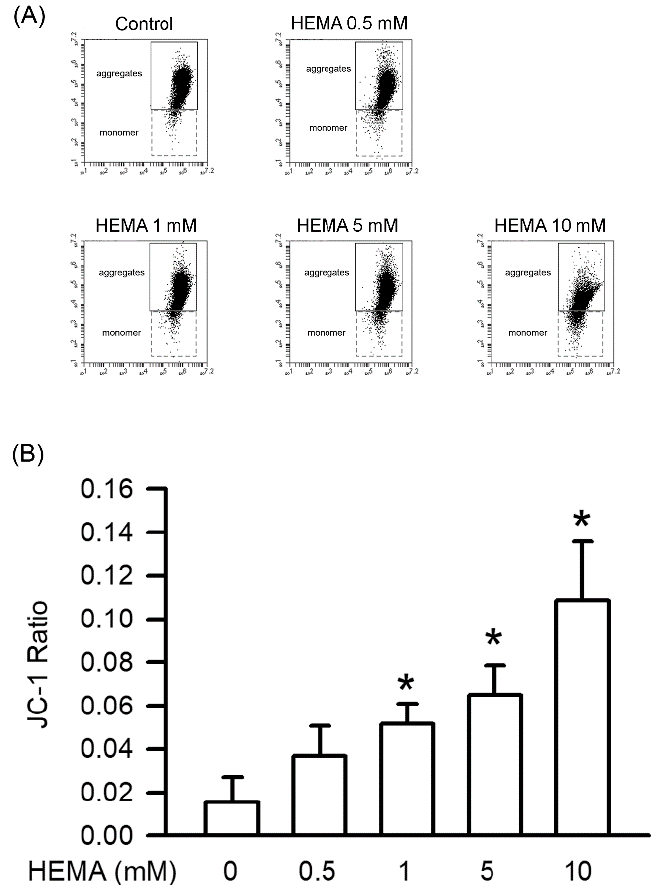
Figure 5. HEMA caused mitochondrial dysfunction. The mitochondrial dysfunction was measured with JC-1 after 24 h of HEMA treatment. ( A ) The original flow cytometry plot showing the evaluation of the mitochondrial dysfunction in RAW264.7 macrophages incubated with HEMA. ( B ) Quantitatively, the JC-1 ratio of the ratios of monomers/aggregates is shown. Data are expressed as mean ± SD. The number of parallel measurements is 4. * means that p < 0.05 compared with HEMA at the concentration of 0 mM. Table 2. The parameters of mitochondrial dysfunction in RAW264.7 macrophages exposed to the different concentrations of HEMA for 24 h via JC-1 staining.